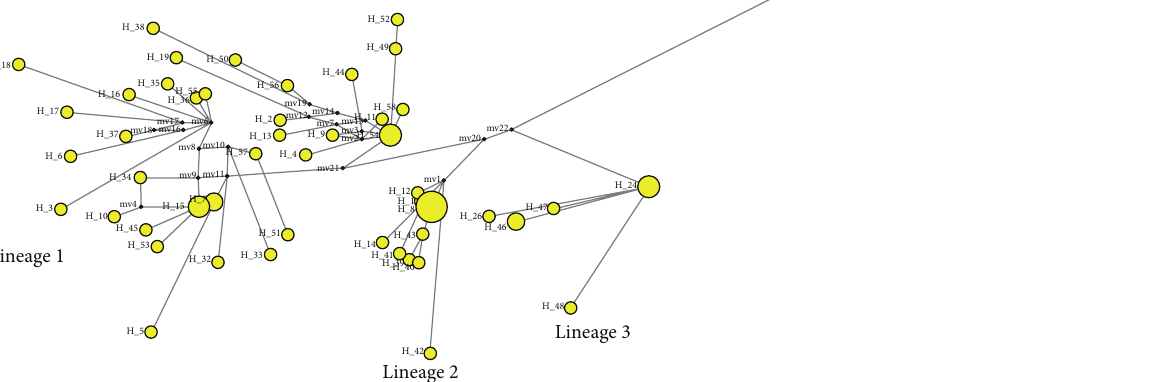
and Hooghly rivers and also felt the need of advanced genetic markers like ATPase 8/6, nicotinamide dehydrogenase sub- unit 2 (ND2), and microsatellite for confirmation. Our results also strengthen the presence of more than one stock of Hilsa in Indian subcontinent; however Ganga and Hooghly Feeder Canal and Hooghly populations shared the same